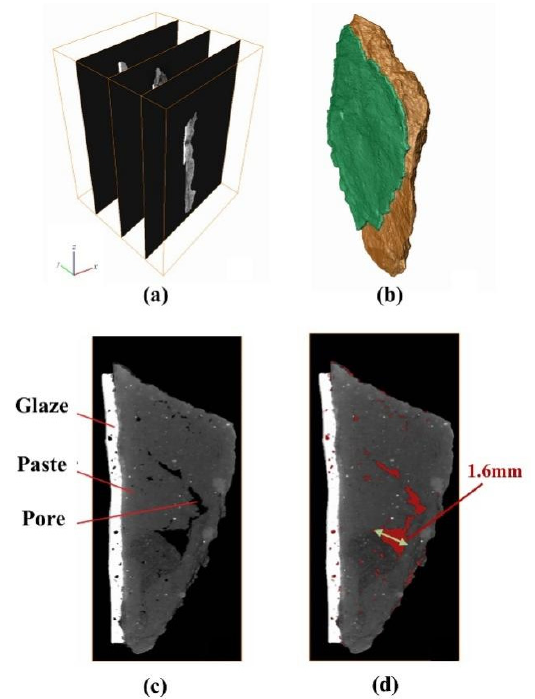
Figure 10. ( a ) The raw CT scanning grayscale slice sequence; ( b ) The 3D reconstruction model; ( c ) The middle cross-section image in grayscale; ( d ) The extracted pore area of the middle cross-section. (Note: sample T-15; the green part of 3D reconstruction model is the glaze layer of the sample, the pore area is rendered in red).